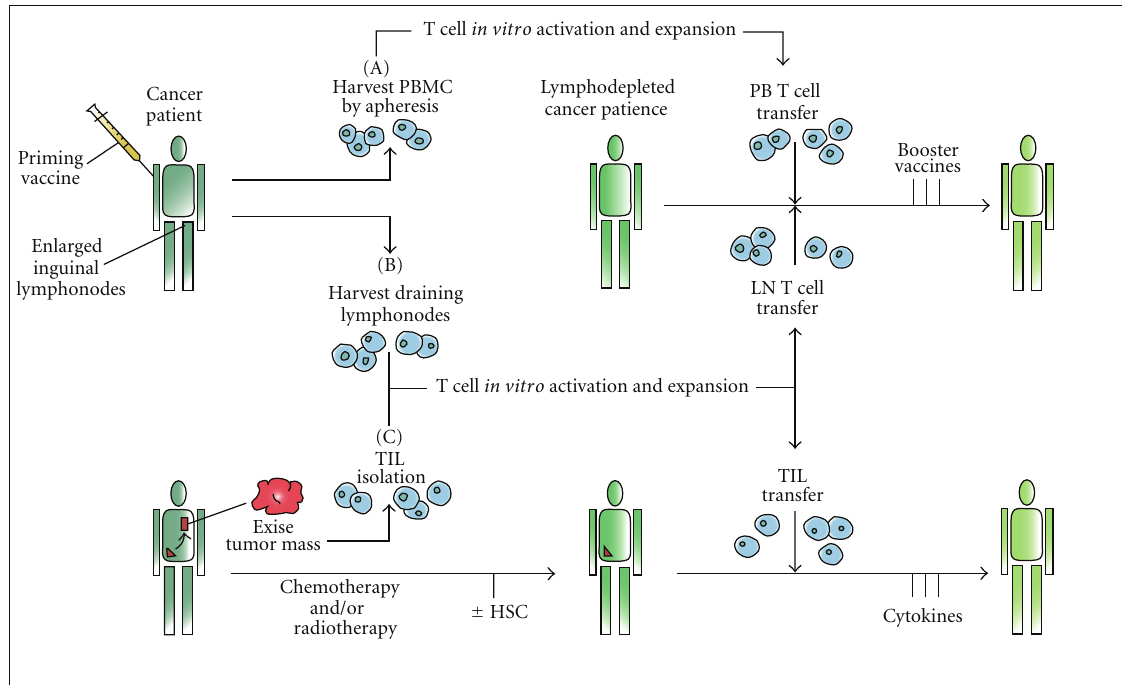
Figure 3: Di ff erent schemes for adoptive transfer of autologous, vaccine-primed, in-vitro -expanded T cells. Patients are primed with tumor vaccine followed by lymphocyte harvest. Autologous T cells are harvested from peripheral blood (I) or draining lymph nodes (II), undergo polyclonal in vitro activation and expansion, and are reinfused after lymphodepleting chemotherapy. Antigen-specific immune function is measured subsequent to the administration of booster vaccines. (III) TILs can be isolated from resected surgical samples and expanded in vitro for adoptive transfer after lymphodepleting chemotherapy. Most adoptive transfer therapy approaches using TILs have involved the use of IL-2 infusion following T cell transfer in order to select tumor-specific T